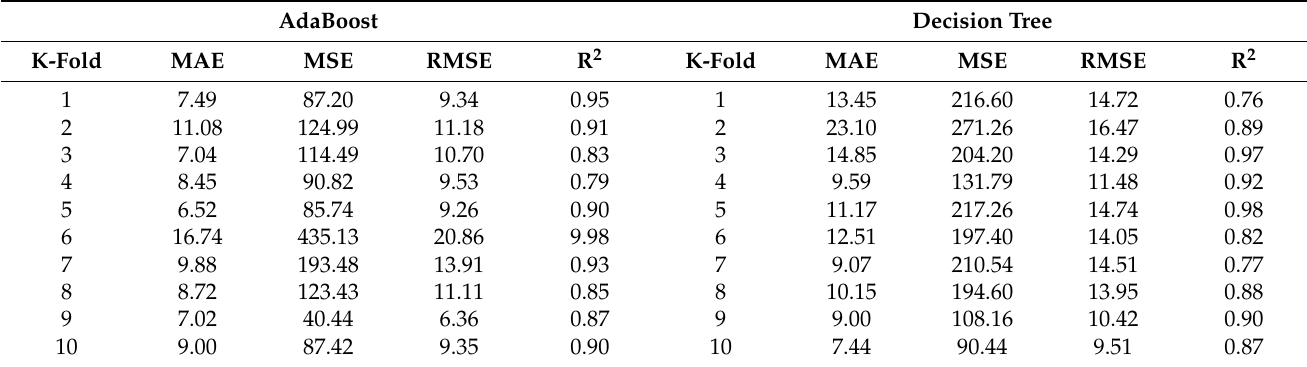
Table 3. Result of k-fold cross-validation for compressive strength.